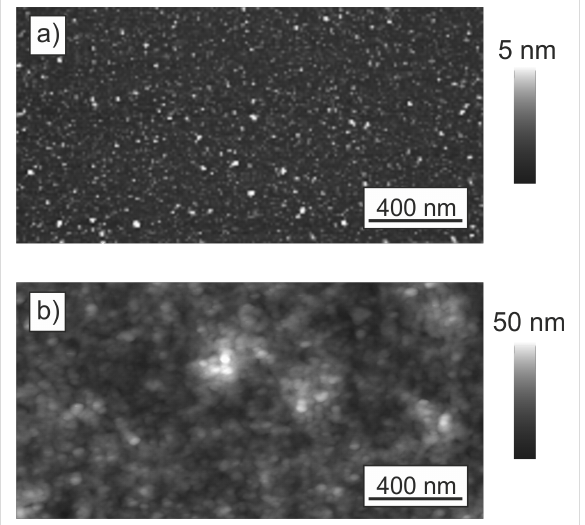
Figure 1: AFM height images of the COOH-SAM (a) and the PEL (b).